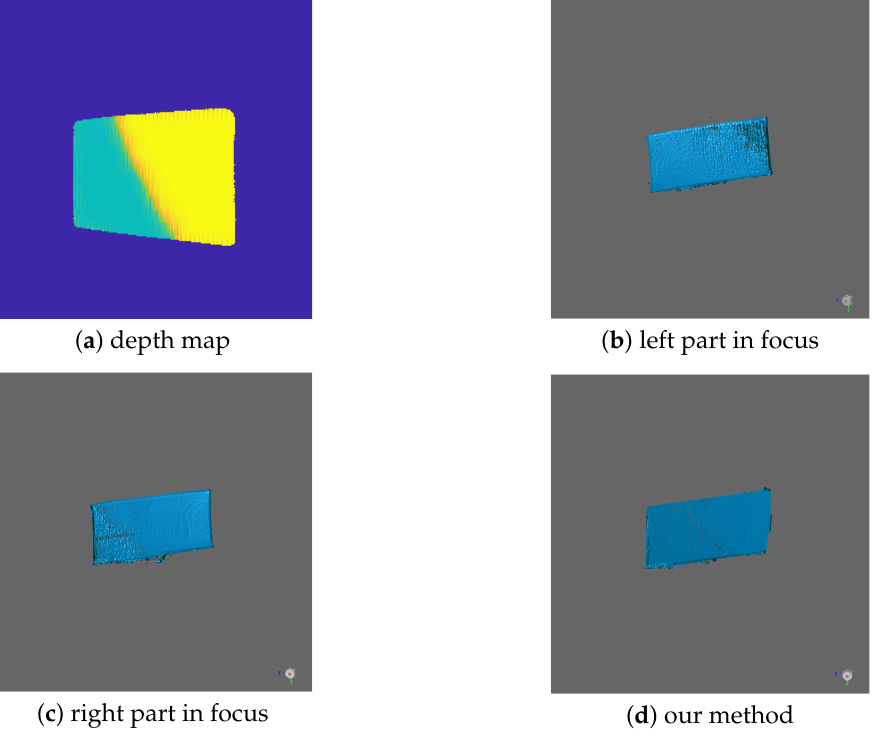
Figure 9. Comparison of measurement results. The scene includes one object having a large depth range. ( a ) The global coarse depth map; ( b ) the left part in-focus; ( c ) the right part in-focus; ( d ) our